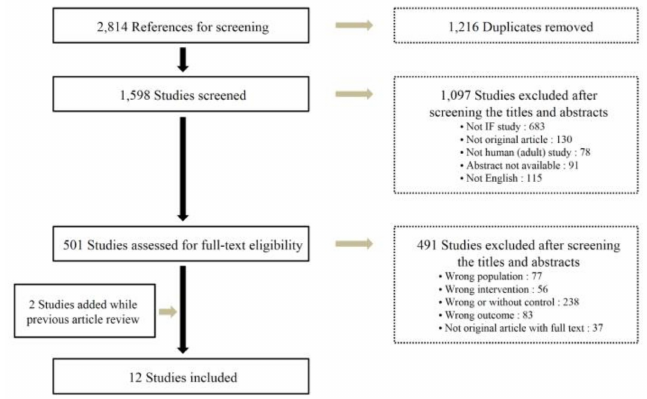
Figure 1. Flowchart of the study